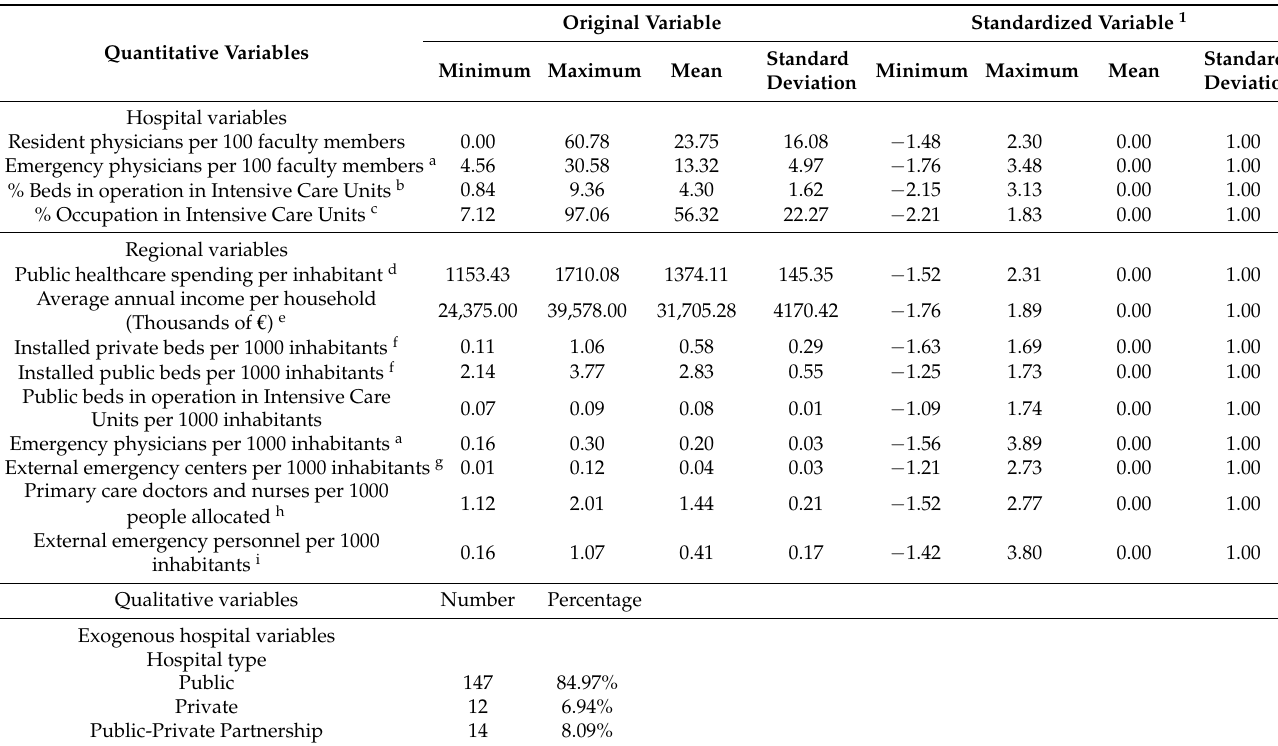
Table 2. Regional and hospital variables in the second stage analysis in the evaluation of technical efficiency of Spanish National Health System general hospitals,